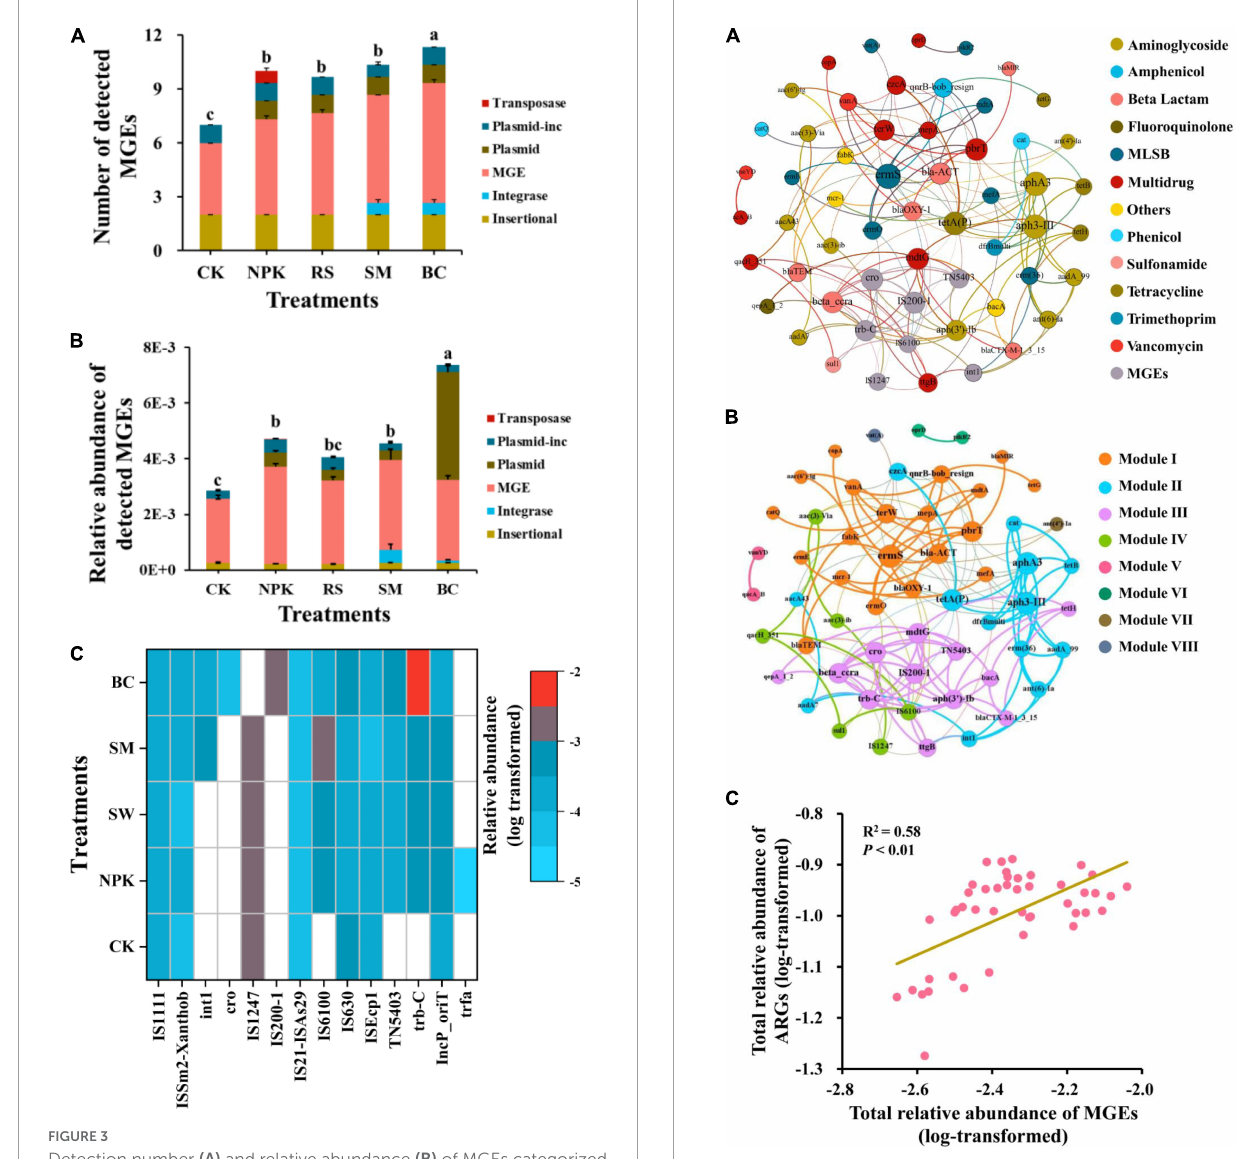
FIGURE4 Correlation between ARGs and MGEs. Network illustrating the co-occurrence patterns among the detected ARGs and MGEs across all the soil samples. The nodes with different colors represent different categories of ARGs and MGEs (A) or different modules (B) . Correlation between the relative abundance of total ARGs and MGEs (C)